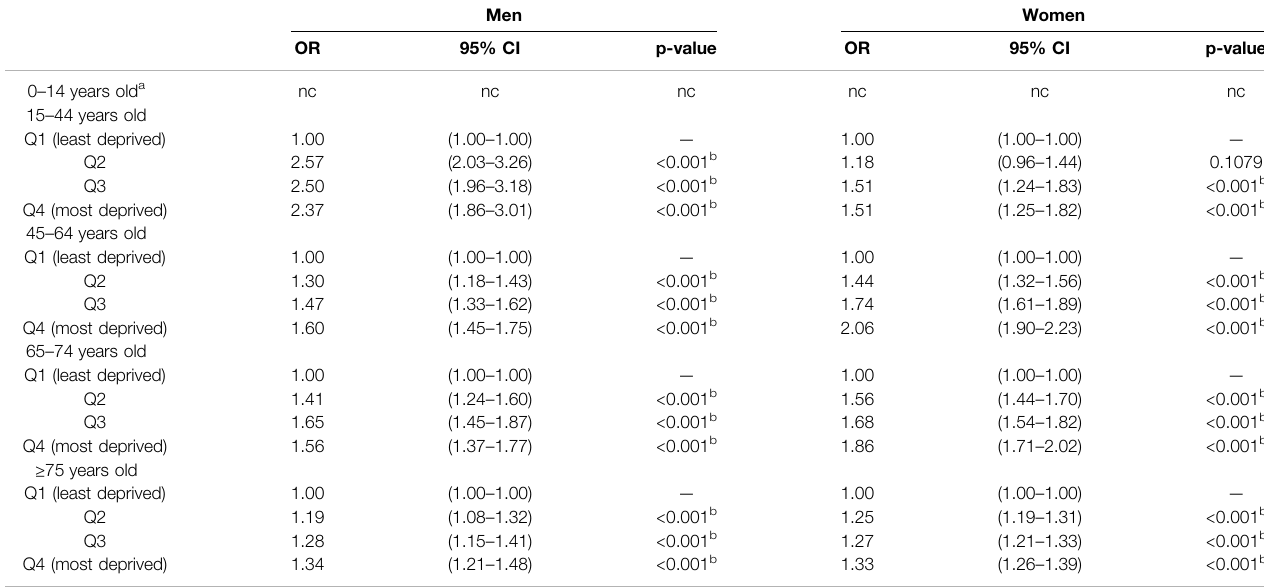
TABLE 4 | Odds ratio (OR) of strong opioids use by sex, age, and composite socioeconomic index (quartiles), adjusted for cancer diagnosis and age in Catalonia,